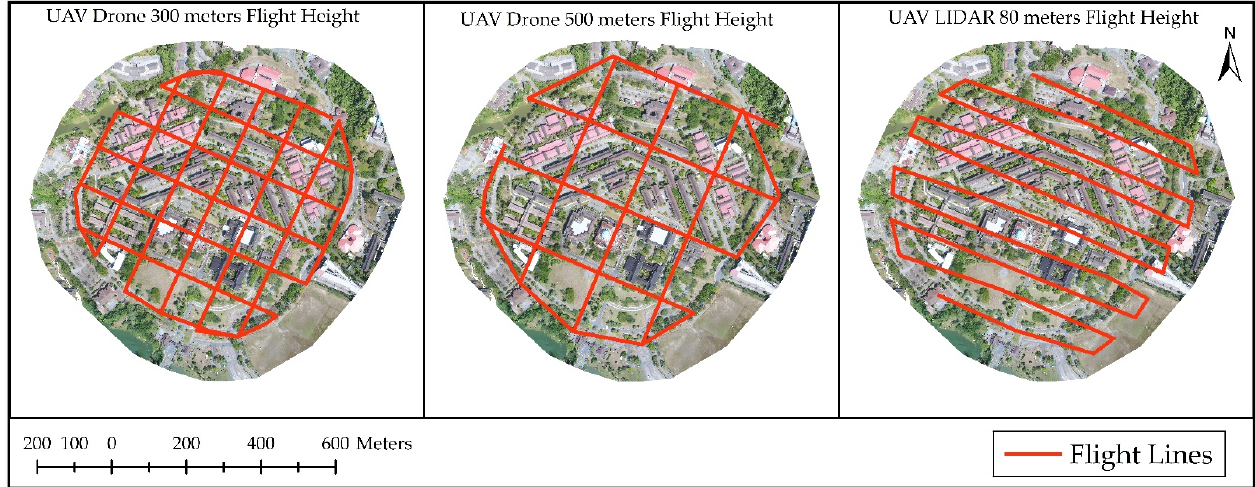
Figure 2. Flight Plans for 300 m ( left ), 500 m ( center ) and LIDAR 80 m ( right ). Table 1. Unmanned Aerial Vehicle (UAV) Flight